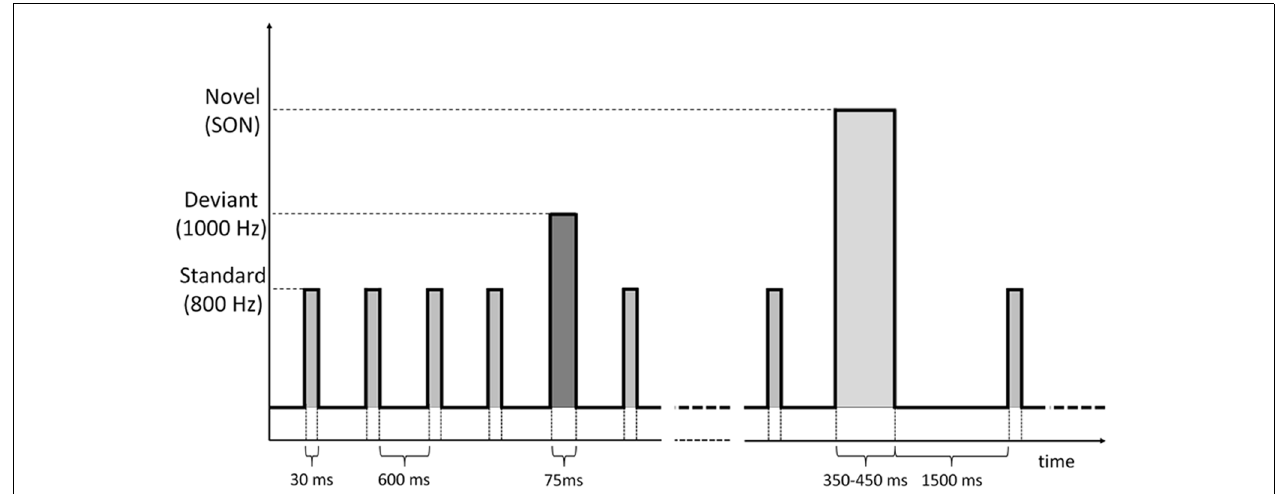
FIGURE 1 | Time sequence of standard, deviant and novel (SON) stimuli administered through the auditory oddball